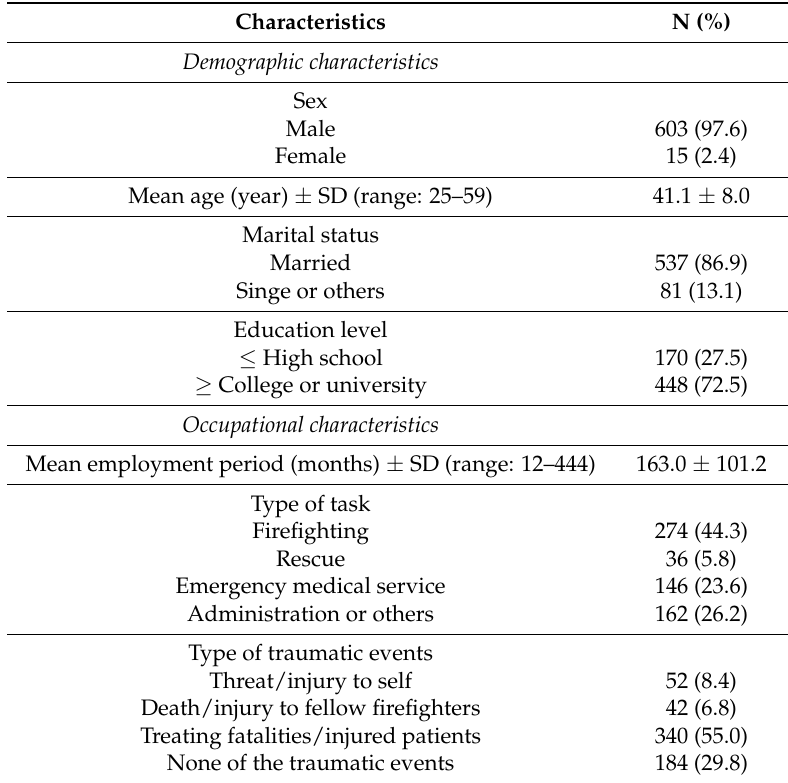
Table 1. Demographic and occupational characteristics of participants.